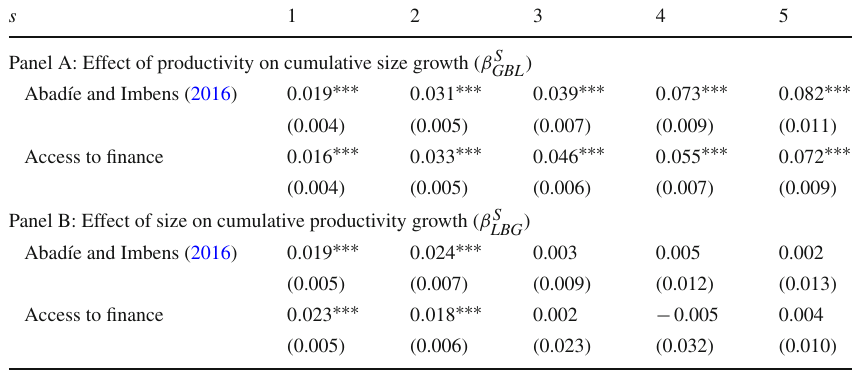
Table 7 Estimated GBL and LBG effects—Robustness (IV) s 1 2 3 4 5 Panel A: Effect of productivity on cumulative size growth ( β S GBL ) Abadíe and Imbens